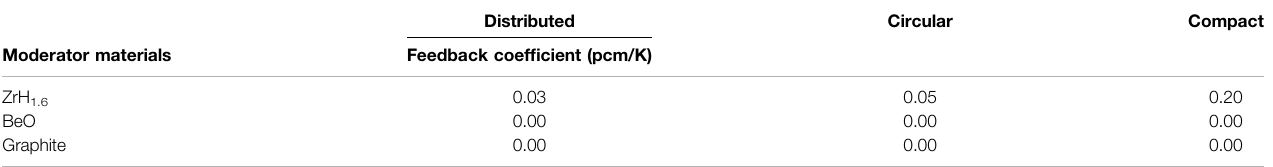
TABLE 7 | Moderator temperature feedback coef fi cient with different arrangement. Distributed Circular Compact